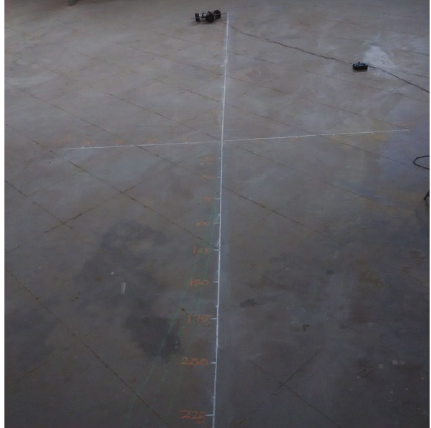
Figure 10: Real-time experiment of forward movement analysis of TWOMR at 𝜃 = 45 ∘